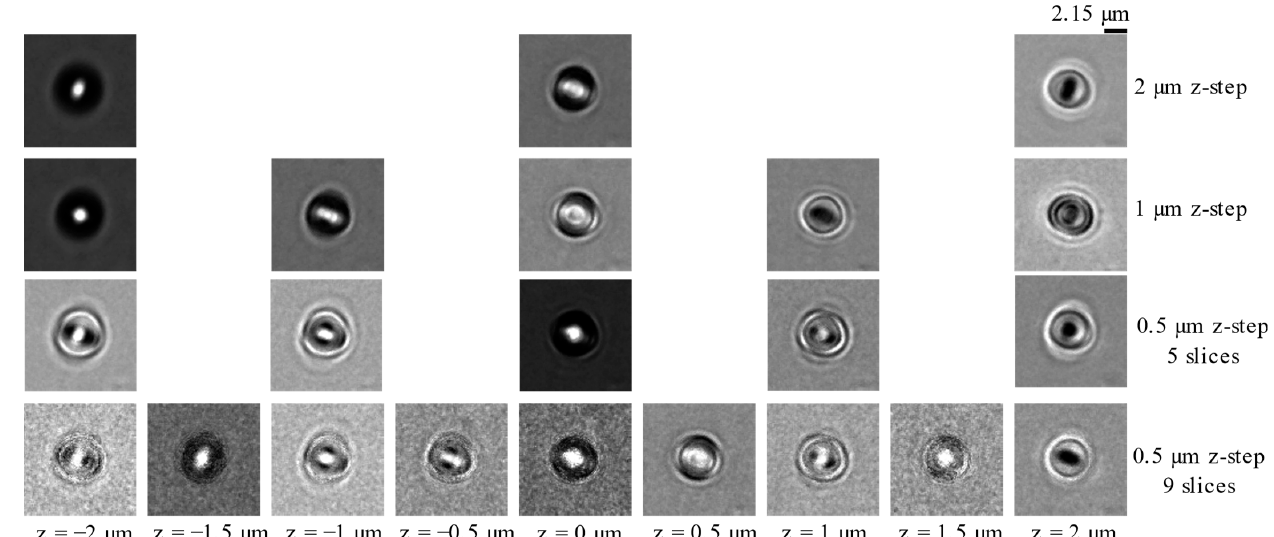
Figure 7. MCR images of single microbead for different z-steps.